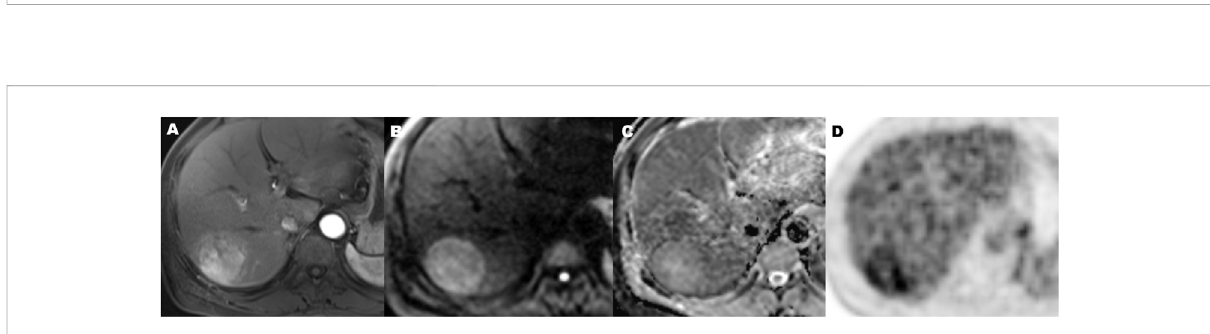
FIGURE 6 A 56-year-old hepatocellular carcinoma in liver segment VII man without microvascular invasion, demonstrating hypervascular enhancement pattern,lowmetabolicofSUVmax3.5,MTV72.2 cm 3 ,TLG196.5,TLR1.9,andADCvalueof1.1×10 − 3 mm 2 /s.Contrast-enhancedMRinarterialphase image (A) ,diffusion-weightedMRimage (B) ,ADCmap (C) ,and 18 F-FDGPET (D) (MTV,metabolictumorvolume;TLG,totallesionglycolysis;TLR,ratio of tumor-to-liver SUV; ADC, apparent diffusion coef fi cient).